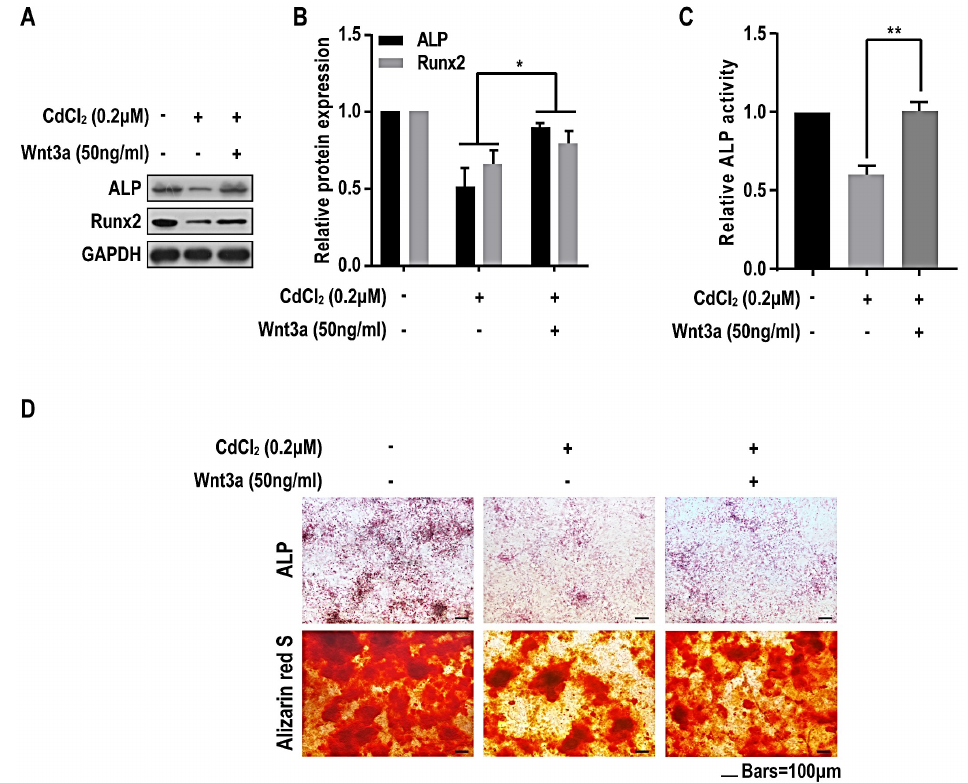
Figure 6. Wnt/ β -catenin pathway is involved in cadmium-induced inhibition of osteoblast differentiation of BMMSCs. BMMSCs were exposed to 0, 0.2 µ M CdCl 2 , or 50 ng/mL Wnt3a with the treatment of 0.2 µ M CdCl 2 in osteogenic medium for 7 days. ( A ) Western blots were performed, and ( B ) relative protein levels of ALP and Runx2 were determined (mean ± SD, n = 3). * p < 0.05, different from control BMMSCs. ( C ) ALP activity was detected by ALP assays (mean ± SD, n = 3). ** p < 0.01, different from control BMMSCs. BMMSCs were exposed to 0, 0.2 µ M CdCl 2 , or 50 ng/mL Wnt3a with the treatment of 0.2 µ M CdCl 2 in osteogenic medium for 14 days. ( D ) The ALP content and the numbers of mineralization nodules were evaluated by ALP staining (upper) and alizarin red S staining (lower). Scale bar, 100 µ